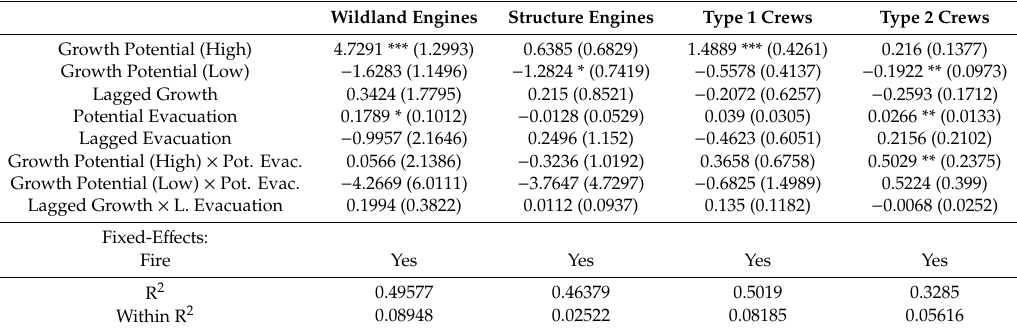
Table 5. Linear fixed e ff ect regression of select suppression resources.